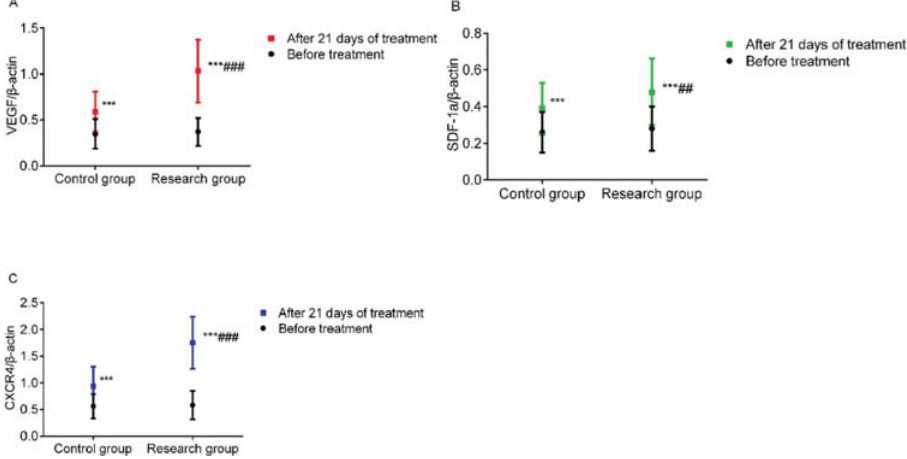
Figure 3 - Comparison of granulation tissue-specific protein expression. A: VEGF levels, B: SDF-1 a levels, and C: CXCR4 levels. *** indicates p o 0.001 when compared to levels before treatment; ### indicates p o 0.001 when compared to the control group. VEGF, vascular endothelial growth factor; SDF-1a, stromal cell-derived factor-1 a ; CXCR4, chemokine receptor 4.